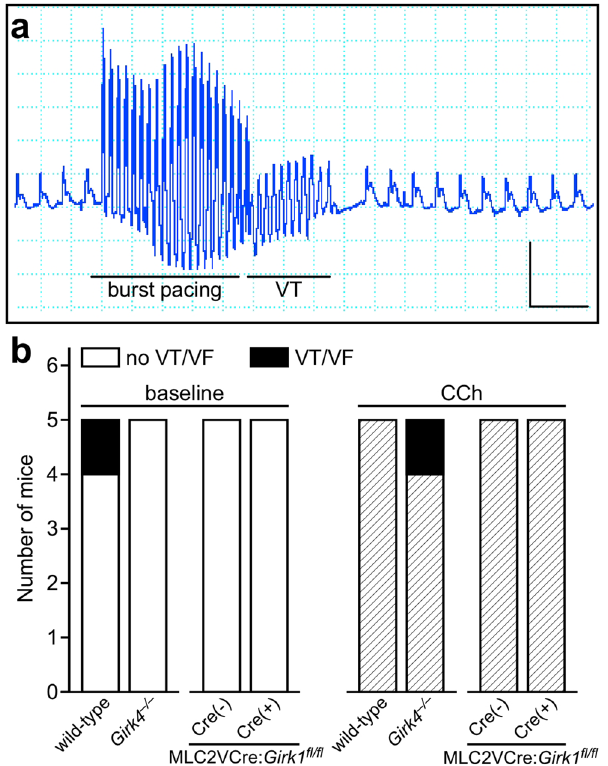
Figure 8. Susceptibility to pacing-induced ventricular arrhythmias in constitutive and ventricle-specific Girk − / − mice. ( a ) Recording of a VT episode after infusion of CCh (3 μ M) and burst pacing of the left ventricle. Scale: 0.5 V/0.2 s. ( b ) Summary of the number of mice exhibiting VT/VF episodes after burst pacing of the left ventricle at baseline (left) and after CCh perfusion (right). Fisher’s exact test revealed no differences in the occurrence of VT/VF episodes between wild-type and Girk4 − / − mice, either at baseline ( P = 1.0) or after CCh administration ( P = 1.0). We did not observe any incidents of VT/VF in MLC2VCre( − ): Girk1 fl/fl or MLC2VCre( + ): Girk1 fl/fl mice, either at baseline or after CCh